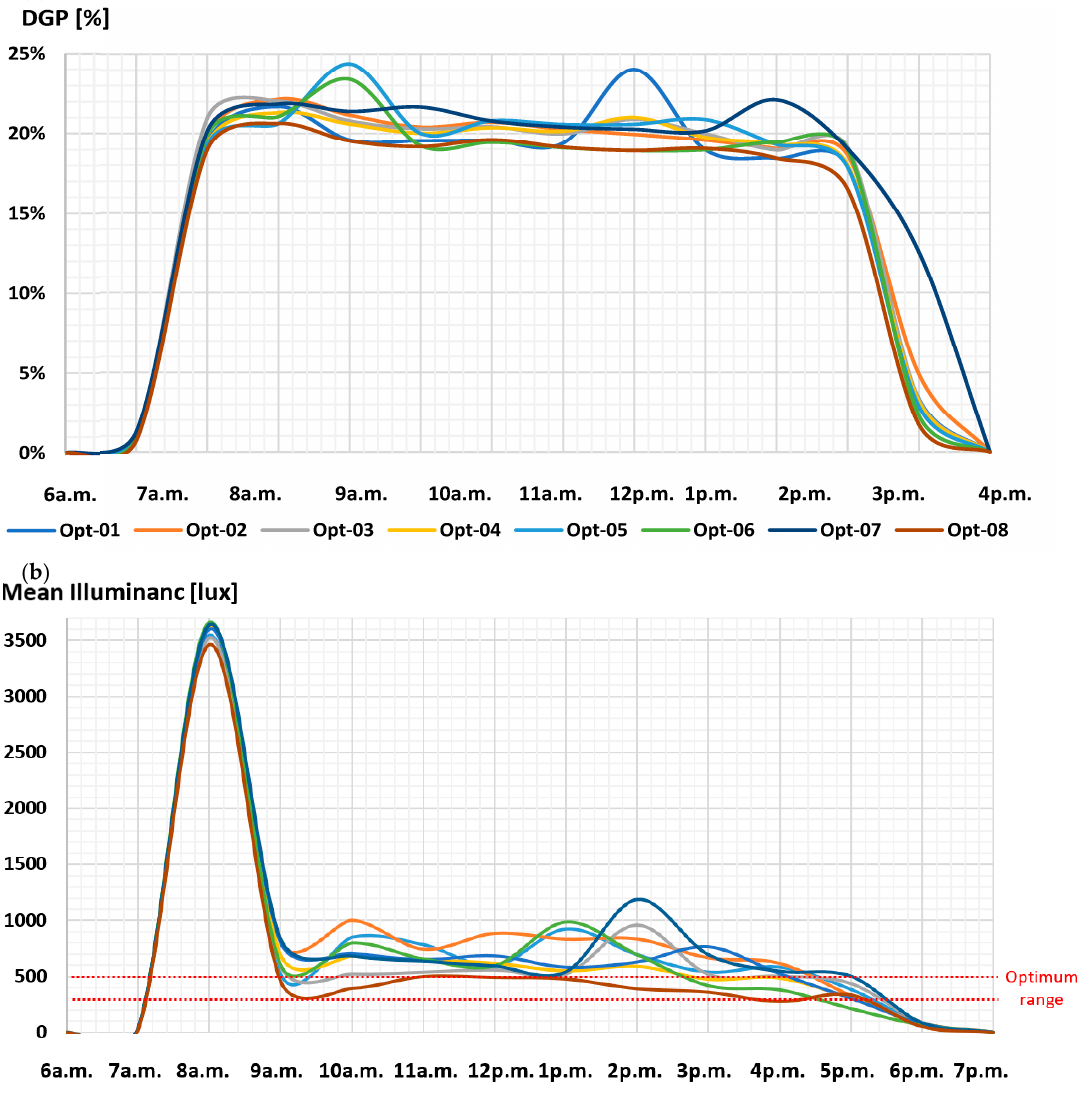
Figure 8. An example of hourly analysis of SLS element properties effect on visual comfort: ( a ) DGP; and ( b ) Mean Illuminance for 19 March. The effect of all eight options on the indoor visual comfort metrics was simulated. As long as DGP < 38% (not disturbing), the solution is acceptable.